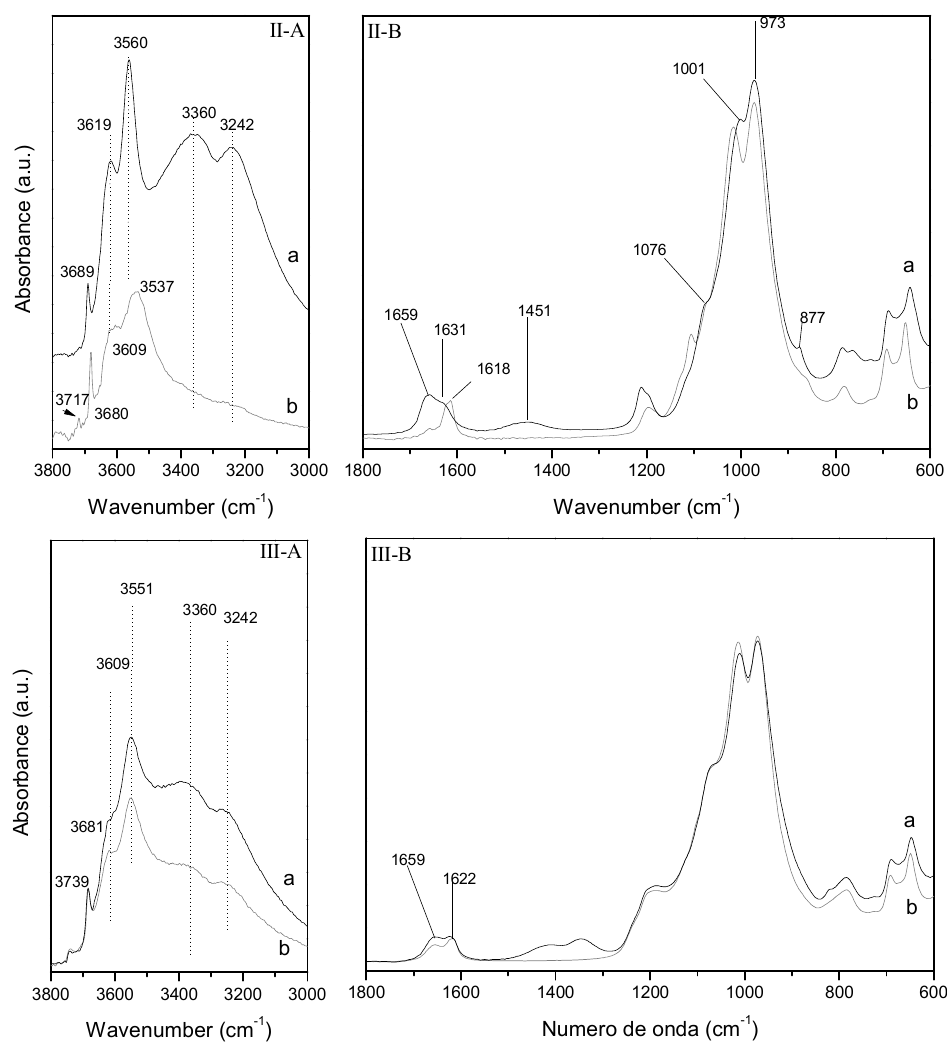
Figure 6. ( I ) Comparison of DRIFT spectra of natural Sm ( a ) vs. Sm–H ( b , grey); ( II ) comparison of DRIFT spectra of natural Sm ( a ) vs. Fe–Sm ( b , grey) and ( III ) comparison of DRIFT spectra of Sm–H ( a ) vs. Fe–Sm–H ( b , grey).